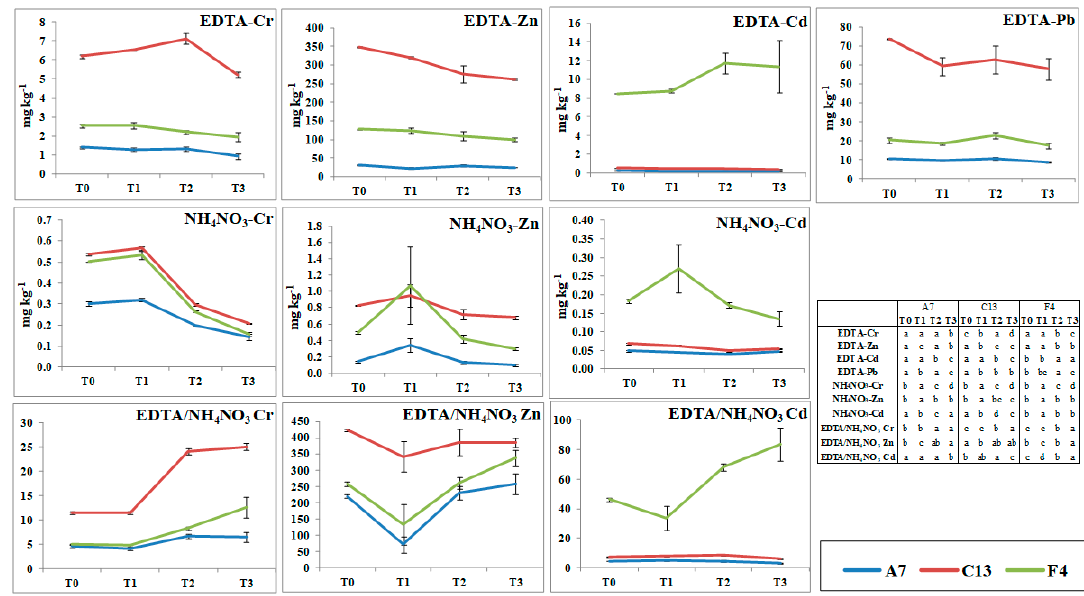
Figure 3. Amounts of Cr, Zn, Cd, and Pb extracted in EDTA and in NH 4 NO 3 , and ratio EDTA / NH 4 NO 3 in the three studied soils at T0 and after each cycle of Brassica juncea (T1, T2, T3). Di ff erent letters for each variable in the table indicate significant di ff erences ( p < 0.05) among the times for each soil. Error bars represent standard deviations.